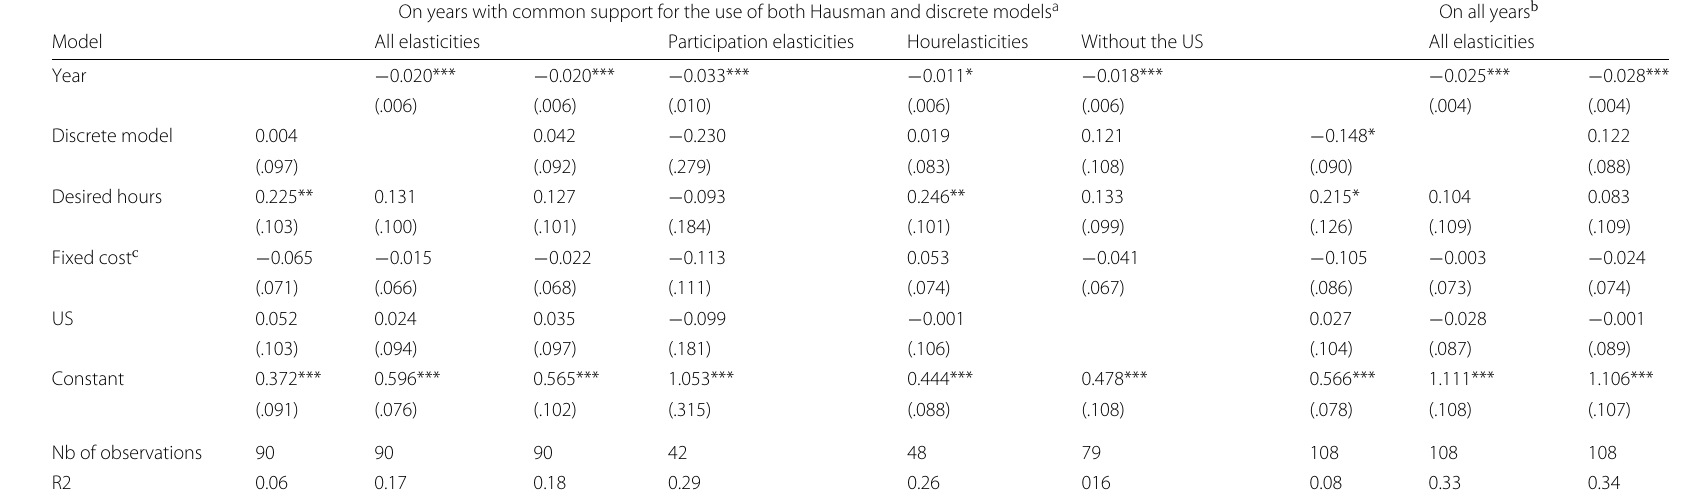
Table 5 Meta-regression of married women and single mothers’ wage elasticities On years with common support for the use of both Hausman and discrete models a On all years b Model All elasticities Participation elasticities Hourelasticities Without the US All